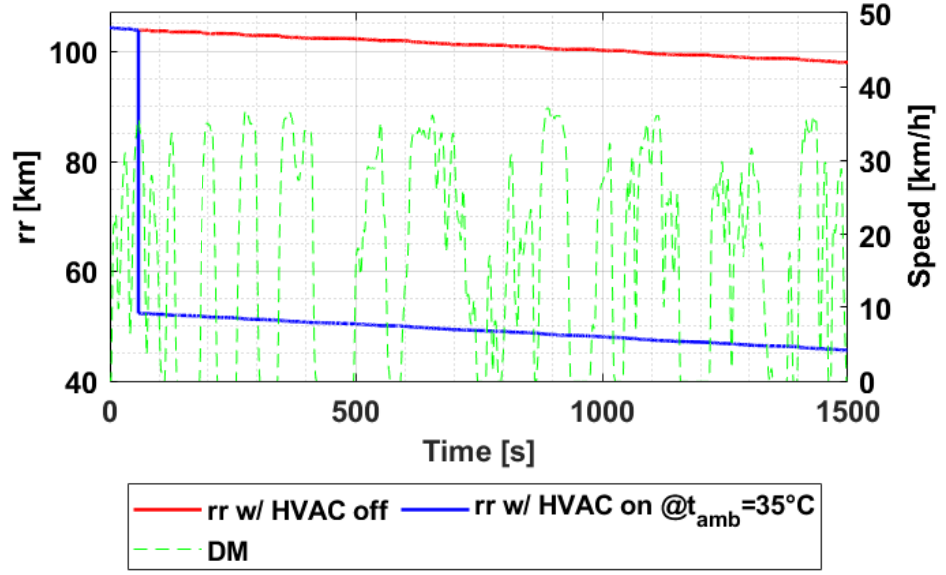
Figure 33. Evolution of the residual range variation with and without the HVAC system consumption for DM 20 considering the summer scenario (35 °C).